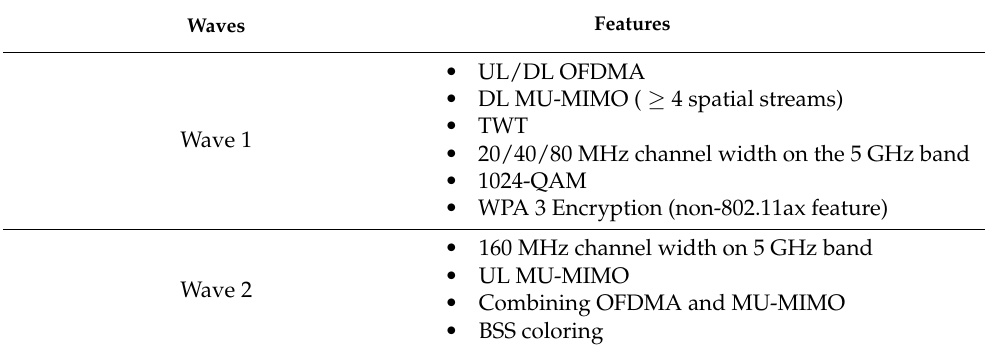
Table 7. The two waves of Wi-Fi 6 access point